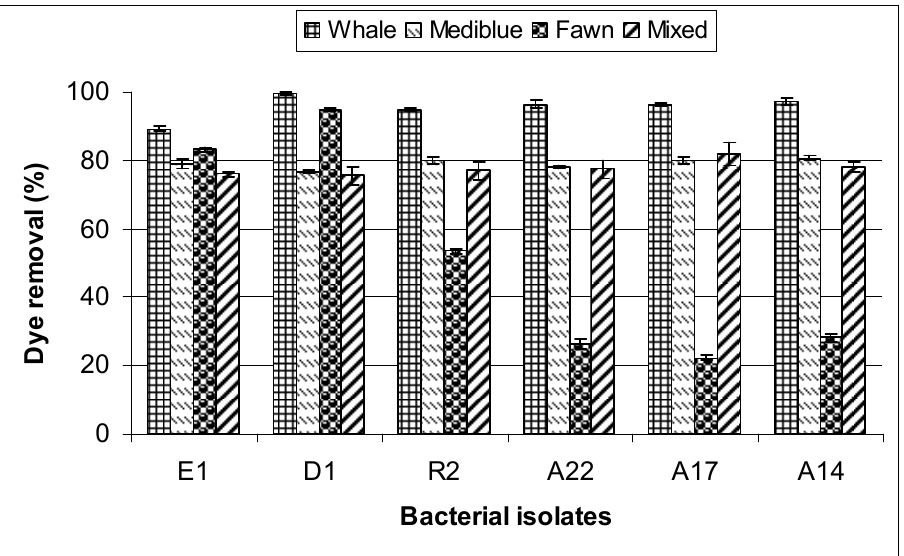
Figure 1. Dye removal from the textile industrial effluents using bioflocculants produced by the bacterial isolates at 10 ppm concentration.